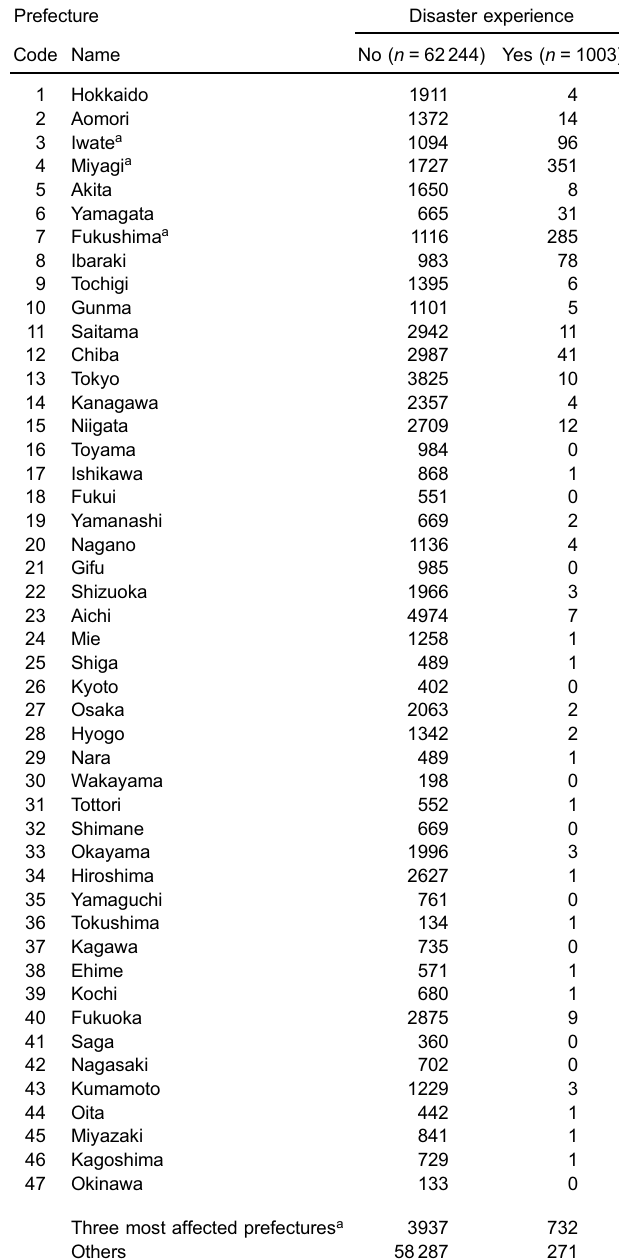
Table 3. Characteristics of nursery school children Children born from April 2, 2004